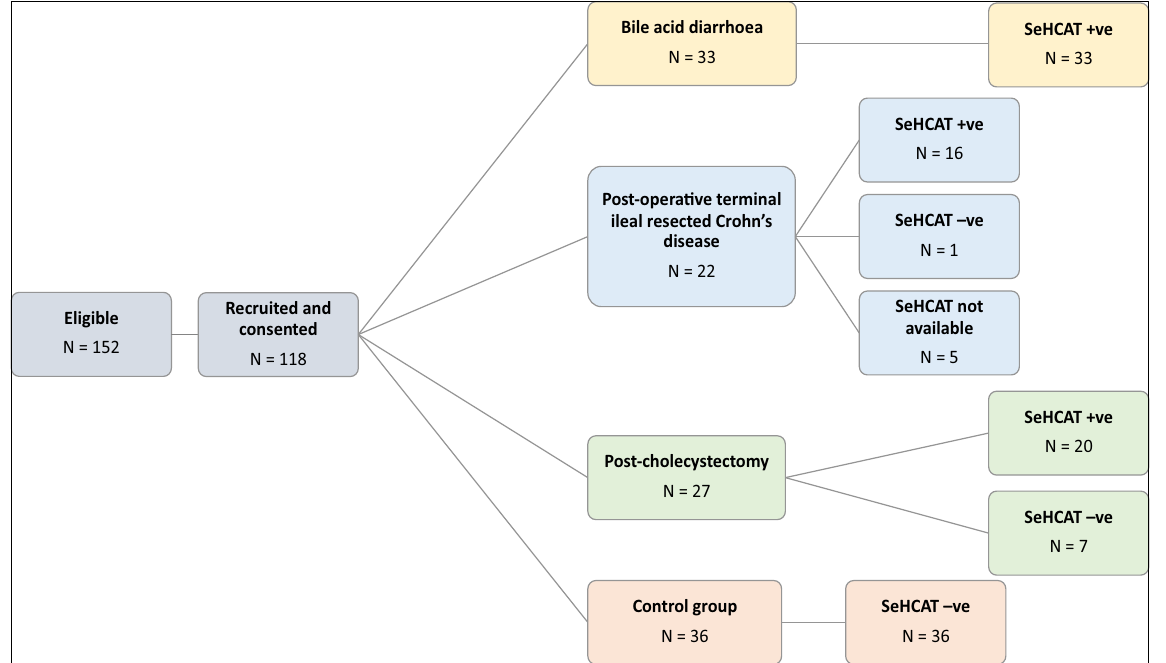
Figure 1. Patient recruitment into four arms of the study. 152 patients were found to be eligible of which 118 consented to partake in study. Following their SeHCAT results and based on their underlying pathology, they were categorised into either idiopathic bile acid diarrhoea, post-terminal ileal resection secondary to Crohn’s disease, post-cholecystectomy group, or SeHCAT-negative Control